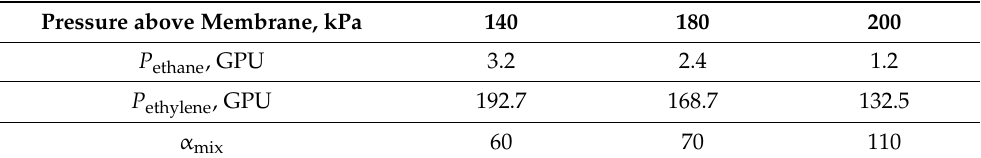
Table 1. Gas permeability of hollow fiber composite membranes over a mixture of ethane and ethylene at different pressures (selection fraction—4%, ethylene/ethane mixture composition—20/80% vol., permeate pressure—5 kPa. A selective layer was formed from 3% AlgNa, crosslinked by AgNO 3 for 5 s and has a thickness 8.3 µ